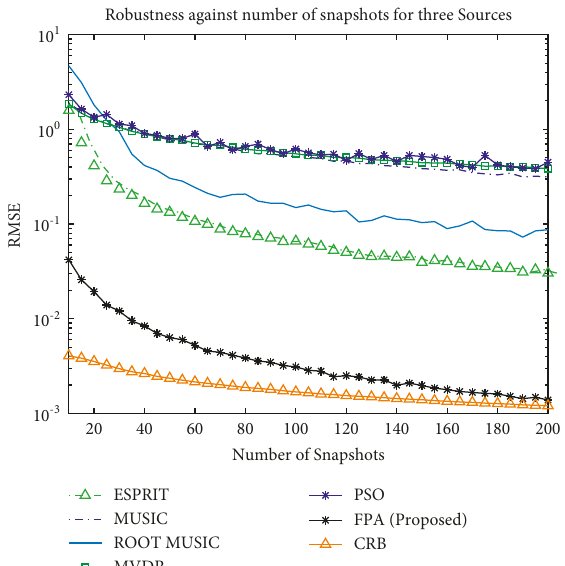
Figure 14: Robustness against snapshots for three sources.